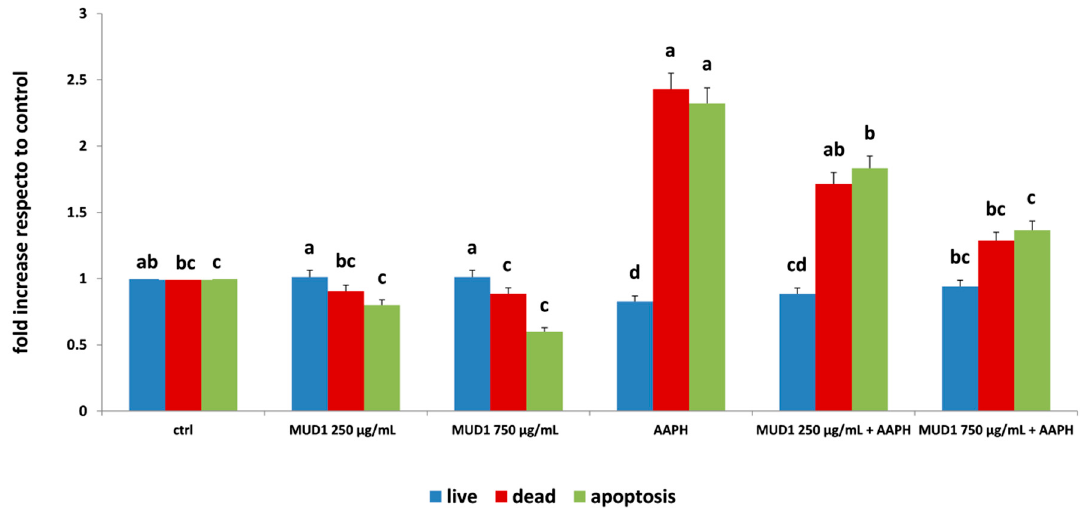
Figure 2. Live (blue bars), dead (red bars), and apoptosis (green bars) levels in HDF cells treated with different concentrations of MUD1 (250–750 µg/mL) for 24 h, AAPH (10 mM) for 24 h and with different concentrations of MUD1 and then with AAPH. Data are expressed as mean values ± SD. Columns belonging to the same set of data with different superscript letters are significantly different ( p < 0.05).